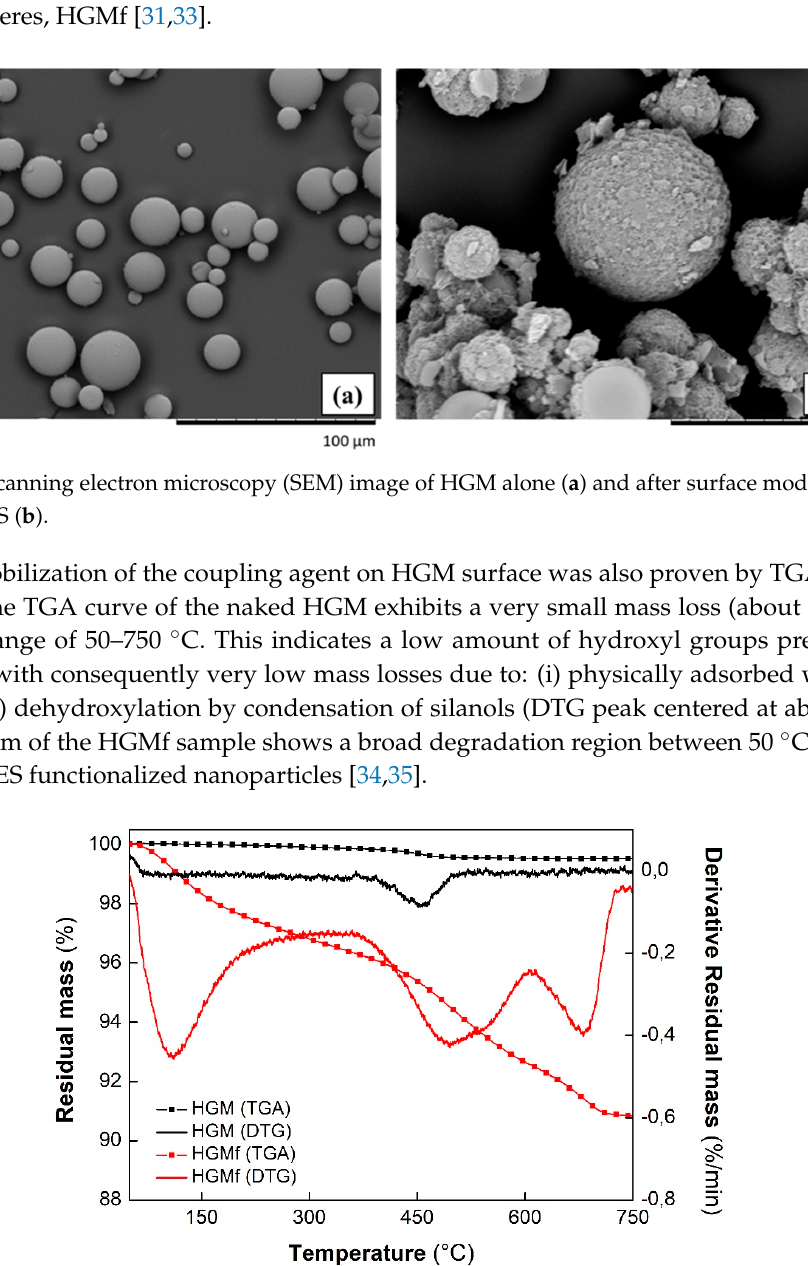
Figure 2. FTIR spectra of naked HGM and HGM functionalized with APTES.